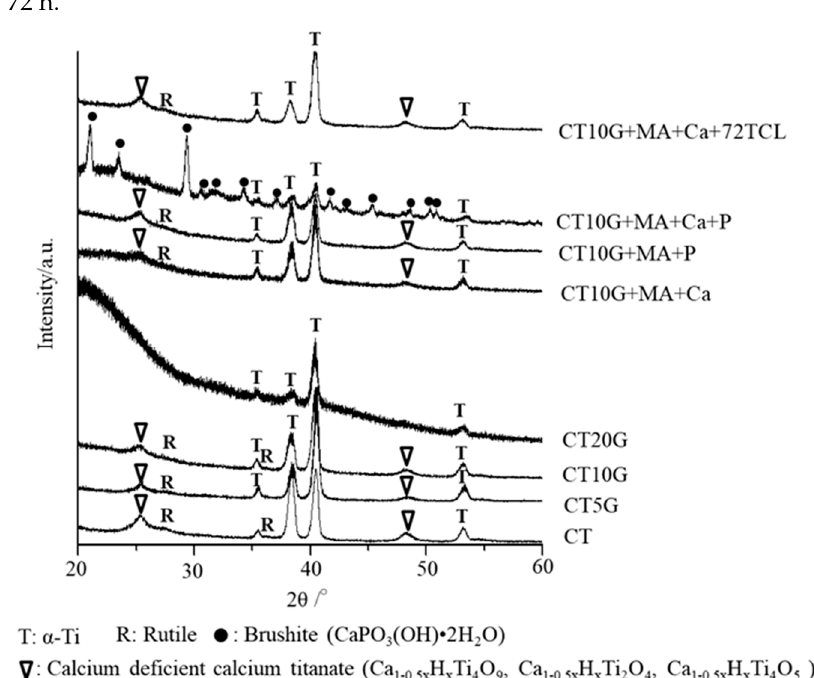
Figure 3. XRD profiles of Ca–heat-treated Ti–6Al–4V alloy subjected to dip coating with various additives and subsequent thermal cross–link treatment. Table 3. Critical scratch loads of the Ti–6Al–4V treated with Ca–heat followed by gelatin coating and thermal crosslinking.